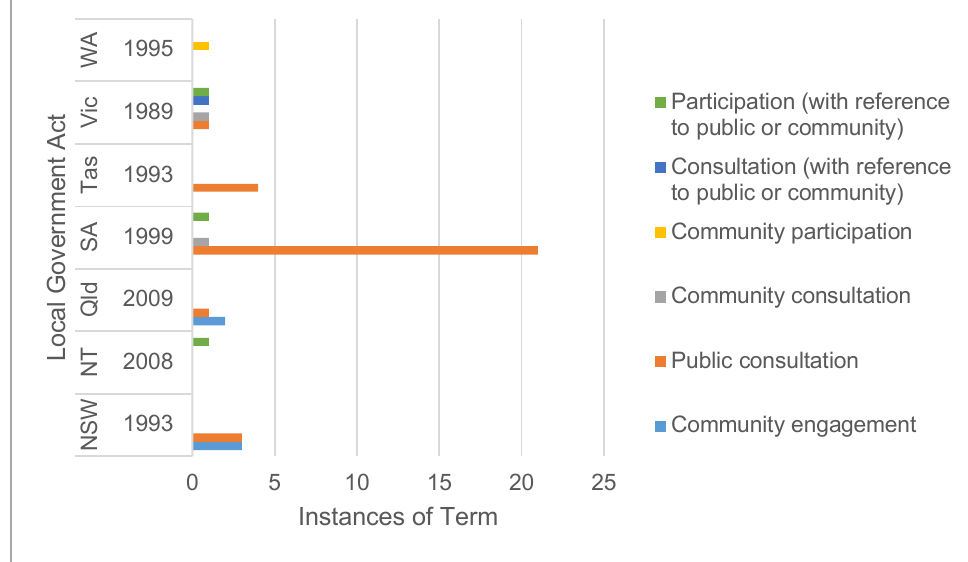
Figure 3: Community engagement terminology in Australia’s Local Government Acts